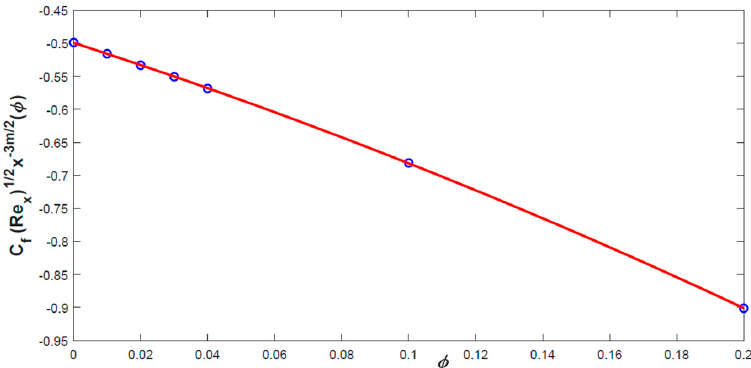
Figure 10. Variation of Re (cid:3051) (cid:2869)/(cid:2870) (cid:1829) (cid:3033) with (cid:2038) (Fe 3 O 4 ) Figure 10. Variation of Re (cid:3051)(cid:2869)/(cid:2870) (cid:1829) (cid:3033) with (cid:2038) (Fe 3 O 4 ) Figure 10. Variation of Re 1/2 x C f with φ (Fe 3 O 4 ).